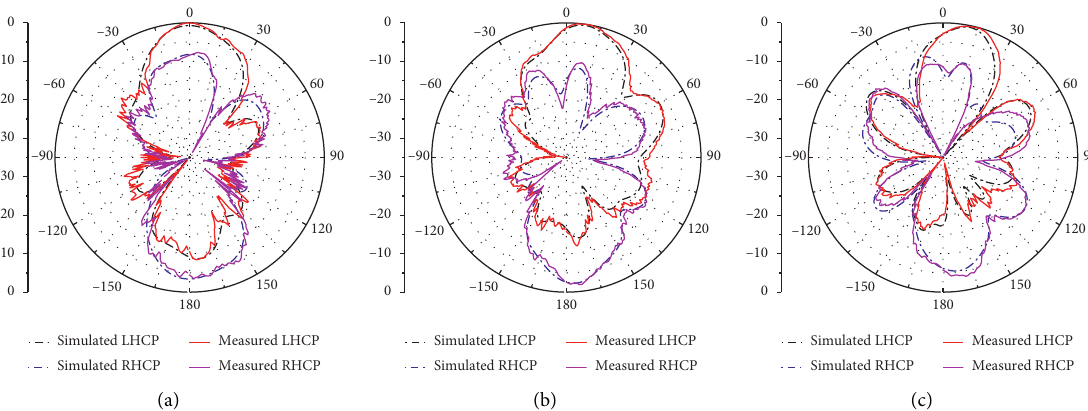
Figure 12: Measured and simulated radiation patterns of the proposed array in the xoz plane: (a) radiation patterns at 25GHz, (b) radiation patterns at 28GHz, and (c) radiation patterns at 31GHz.